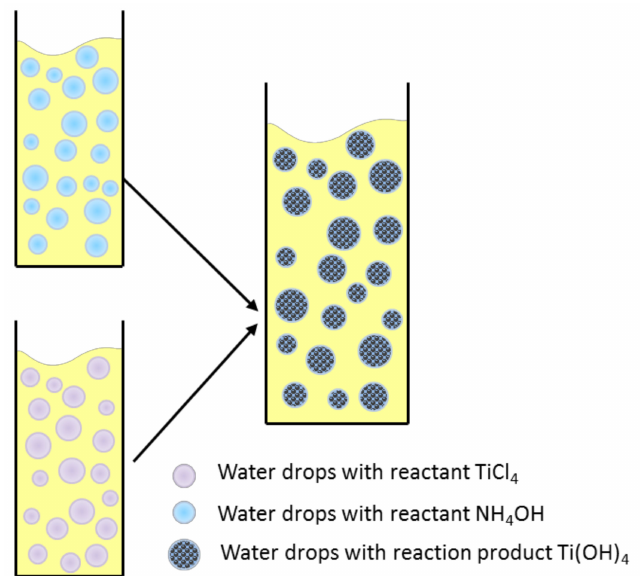
Figure 1. Schematic presentation of the two-emulsion method used in the current study for synthesis of TiO 2 particles and their aggregates. Two initial water-in-oil (W / O) emulsions, containing water drops with the reactants TiCl 4 and NH 4 OH, are mixed and stirred under well controlled hydrodynamic conditions. During this stirring, the drop–drop coalescence leads to mixing of the reactants and to formation of Ti(OH) 4 as a reaction product inside the water drops which play the role of micro-reactors. The subsequent heating of the stirred emulsion transforms the Ti(OH) 4 into TiO 2 particles with predominantly anatase crystal